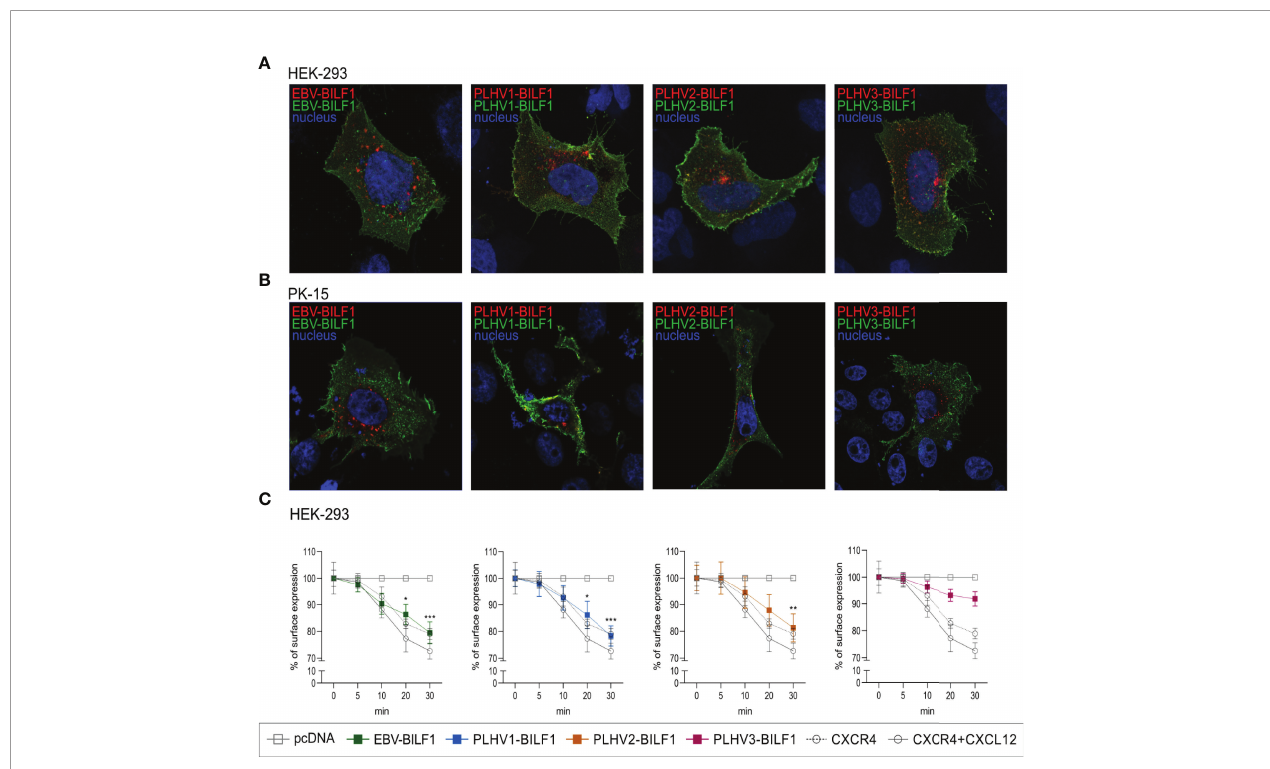
FIGURE 4 | Constitutive internalization of the BILF1 receptor family. (A, B) Antibody feeding based microscopy assay showed internalization of BILF1 receptors in (A) HEK-293 cells and (B) PK-15 cells. Alexa488 antibody (green) was used to label receptors expressed at the cell surface and Alexa 594 antibody (red) to detect the internalized receptors. Nuclei are stained with Hoechst 33342 stain (blue). Images were taken with 63 × oil immersion plan ‐ apochromat objective. (C) Time- course cell-based ELISA internalization assay. Receptor surface expression was determined over time as in cell-based ELISA experiment. CXCR4 was additionally incubated with 10µM CXCL12 as a positive control (values are means ± SEM, n = 3). Statistics were performed by 2-way ANOVA using GraphPad Prism. *p – value < 0.05; **p – value < 0.01; ***p – value <